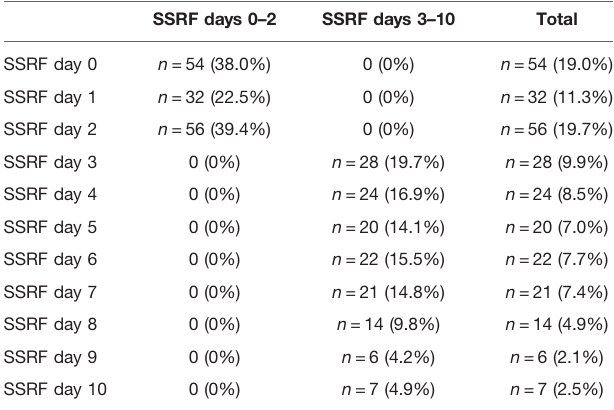
TABLE 3 | Distribution of SSRF days 0 – 10.